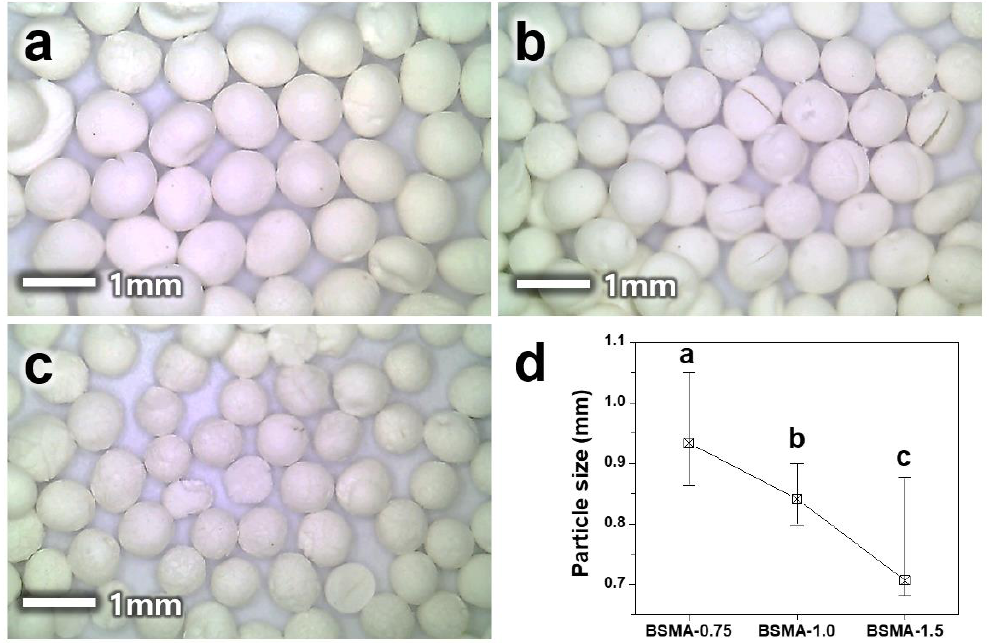
Figure 3. Digital photo images of BSMA samples prepared by using different mole ratio of chitosan to alumina precursor: ( a ) 0.75:1 (BSMA-0.75), ( b ) 1:1 (BSMA-1.0) and ( c ) 1.5:1 (BSMA-1.5). ( d ) Average particle size of each BSMA samples.